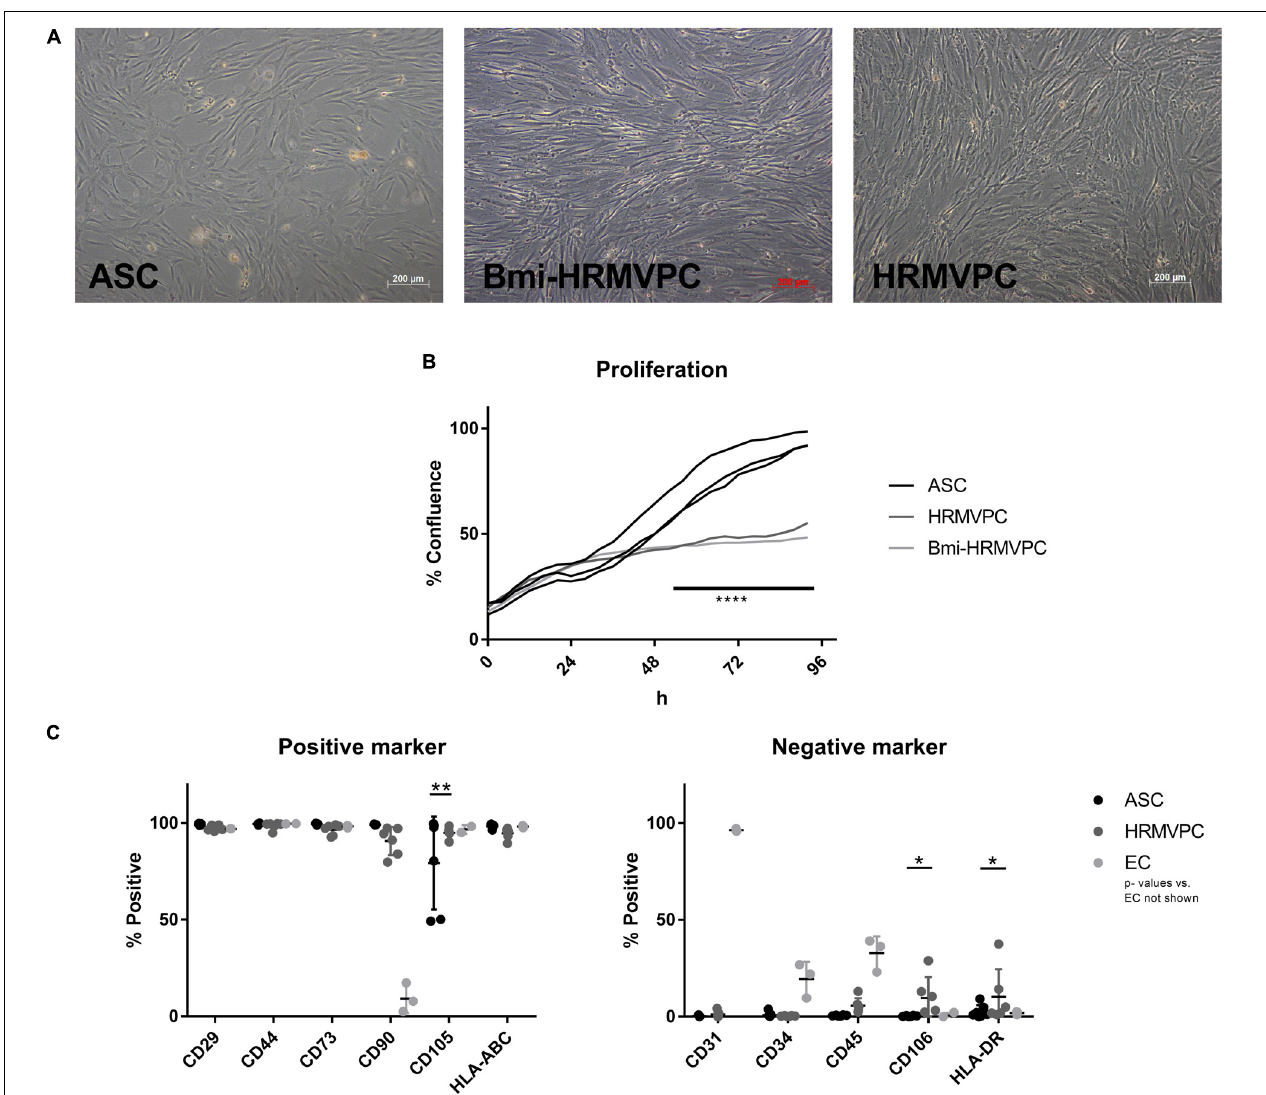
FIGURE 1 | Morphology of adipose-derived stromal cells (ASC) and human retinal microvascular pericytes (HRMVPC) and the growth curves differ, whereas the mesenchymal stromal cells (MSC) marker expression is indistinguishable. (A) Representative images of ASC, Bmi-HRMVPC and HRMVPC. (B) Growth curves of ASC (three different donors), HRMVPC (one donor), and Bmi-HRMVPC cell line determined by kinetic live imaging (**** p ≤ 0.0001, two-way ANOVA with Sidak’s post hoc test). (C) Surface expression of MSC positive and negative markers for ASC ( n = 7 different donors), HRMVPC (HRMVPC and Bmi-HRMVPC groups, n = 6, biological and technical replicates from three different donors), and endothelial cells (EC; n = 3, human umbilical vein endothelial cell and human retinal microvascular endothelial cell groups) (* p ≤ 0.05 and ** p ≤ 0.01, two-way ANOVA with Tukey’s post hoc test; significant differences to EC not depicted).